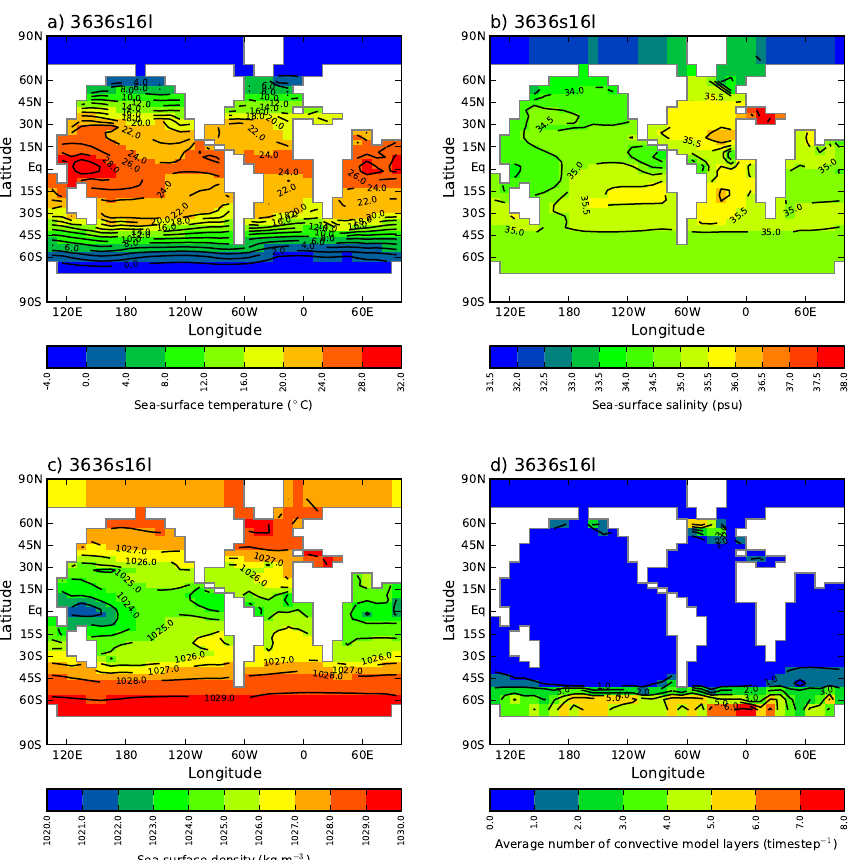
Fig. 9. Annual-mean ocean surface temperature in ◦ C (a) , salinity in psu (b) and density in kg m − 3 (c) , and average convection depth level (d) , for 3636s16l. Density is computed from temperature and salinity, using the model equation of state (Eq. 11 in Edwards and Shepherd, 2001). The convection depth level is a grid-specific diagnostic model output averaged over the whole spin-up simulation. – number of atmosphere time-steps: asynchronous with default of 5 atmospheric time-steps per ocean time-step (i.e., 480 yr − 1 or 960 yr − 1 , depending on the horizontal